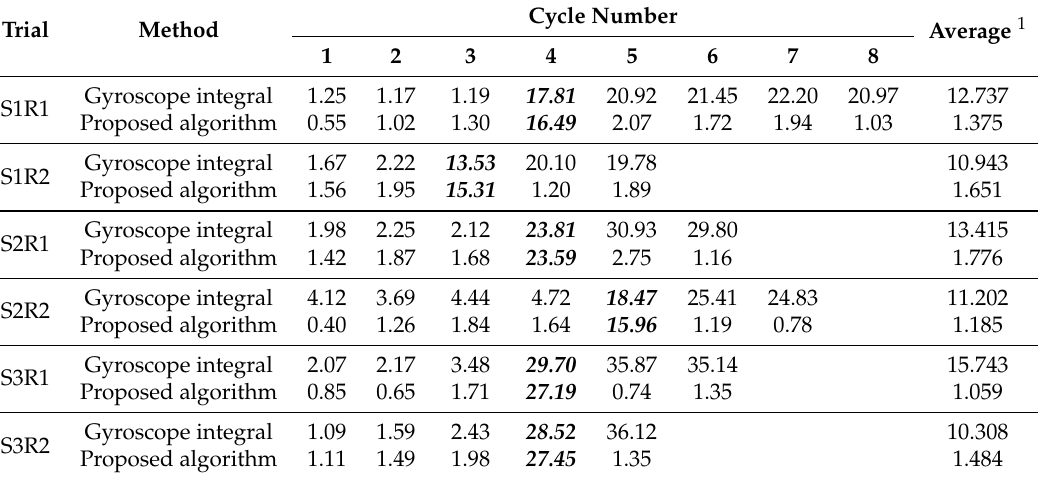
Table 2. RMS errors for the six trials (expressed in degrees). S, subject; R,